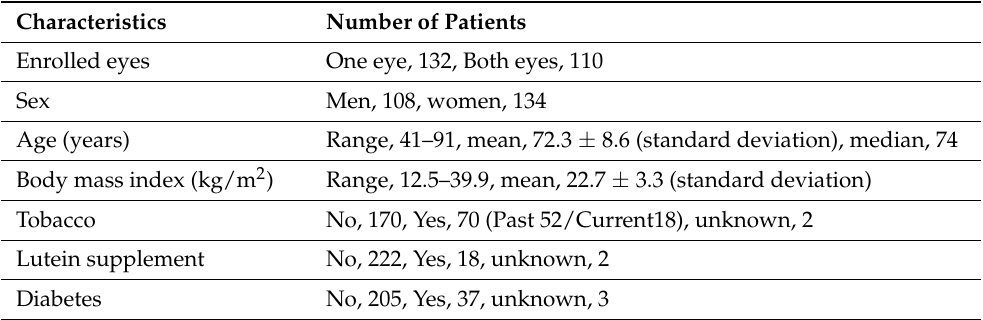
Table 1. Patient characteristics.